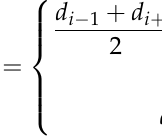
Figure 1. Proposed framework for electricity consumption